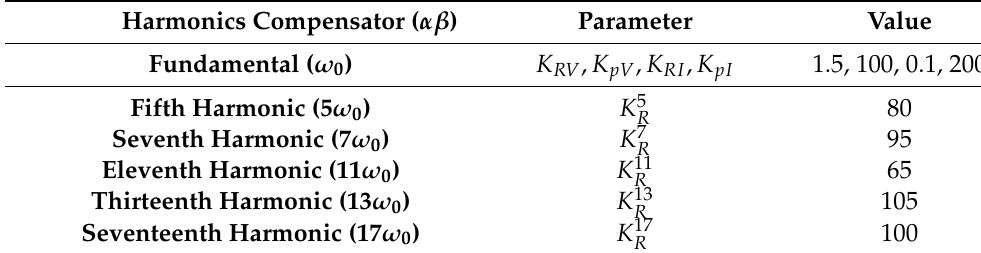
Table 4. Setup parameters for harmonic compensators. Harmonics Compensator ( αβ ) Parameter